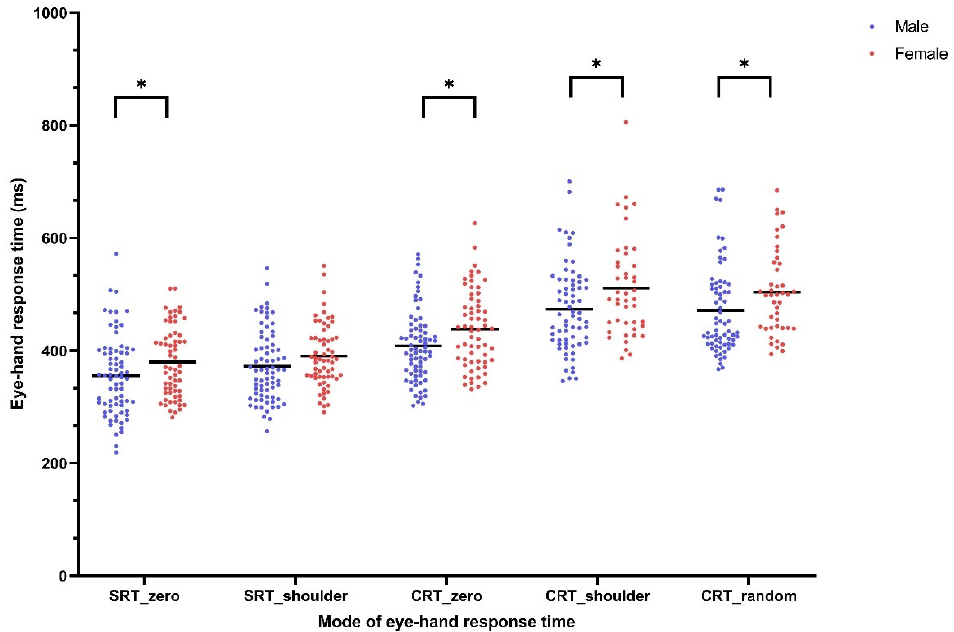
Figure 3. Eye–hand response time of male and female college students measured in five modes of eye–hand response time. (*: statistical significant between males and females)